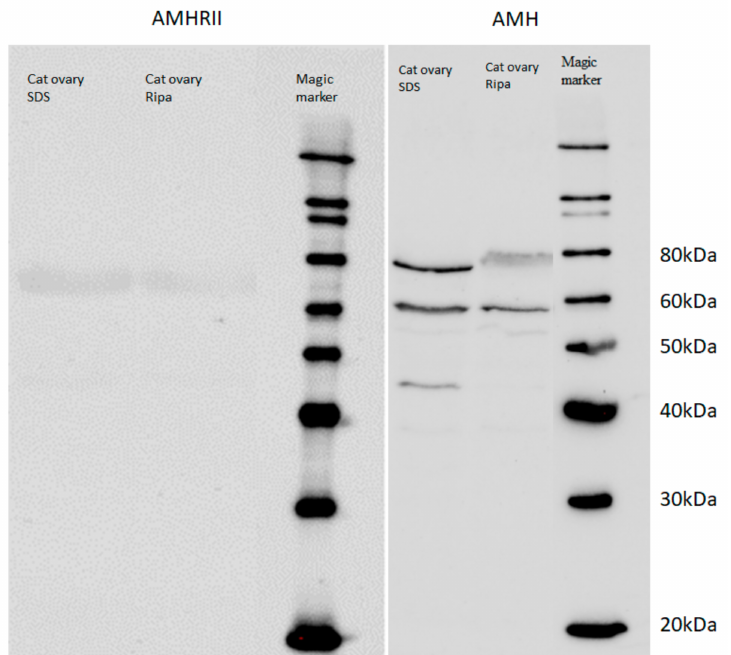
Figure 1. AMH- and AMHRII—Western blot analysis. Western blot detection of the AMH and AMHRII protein—note the bands of about 60–80 kDa in the cat ovary cells. Ripa = Ripa lysis buffer, SDS = SDS lysis buffer. Antibody-dilution: